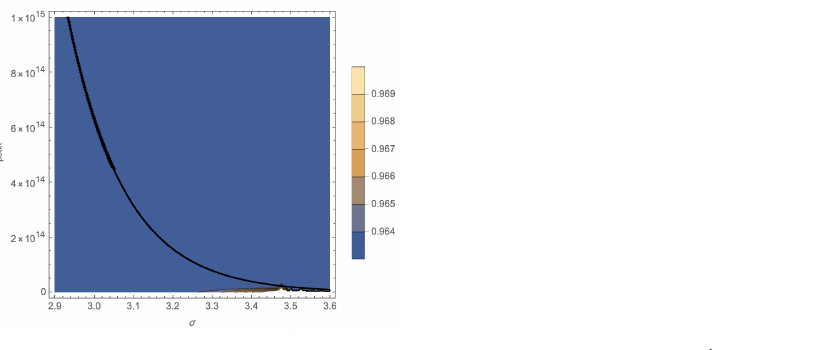
Figure 3. The impact of Equation (38) on the parameters for 10 14 Mpc − 1 ≤ k peak ≤ 10 15 Mpc − 1 in the ( σ , k peak ) -plane. The (excluded) area above the black curve leads to the right end of the peak after the end of inflation. The other parameters are P 0 = 6.57 × 10 − 13 and k final = 7.7 × 10 23 Mpc − 1